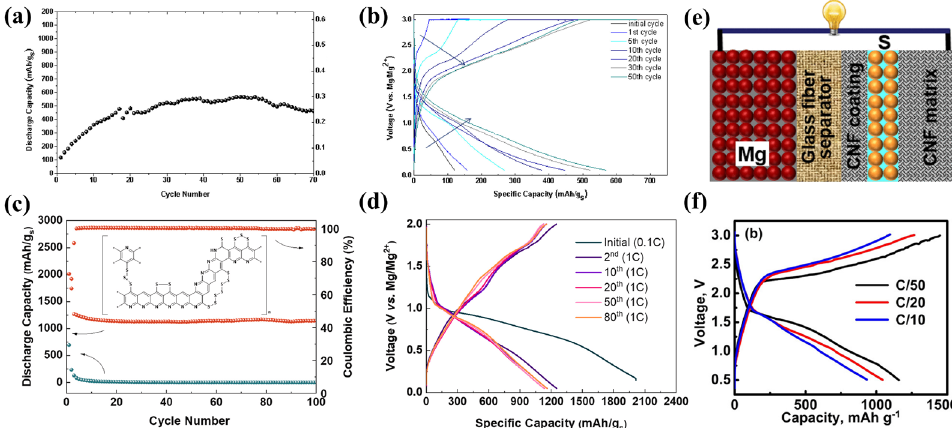
Figure 11. ( a ) Cycling performance of SPAN cathode in 0.8 M Mg[B(hfip) 4 ] 2 electrolyte at 0.033 C and corresponding ( b ) discharge −charge profile [82] . ( c ) Cycling performance of SPAN cathode with the Mg 2+ /Li + electrolyte (orange) and the Mg 2+ electrolyte (green) at 1 C (inset: chemical structure of SPAN). ( d ) Discharge −charge profile of SPAN in 0.2 M Mg(CF 3 SO 3 ) 2 − 0.4 M MgCl 2 − 0.4 M AlCl 3 − 1.6 M LiCF 3 SO 3 electrolyte [42] . ( e ) Schematic of a CNF − coated separator in Mg − S cell and the corresponding ( f ) discharge −charge profile in Mg(HMDS) 2 − MgCl 2 − AlCl 3 electrolyte [56] .